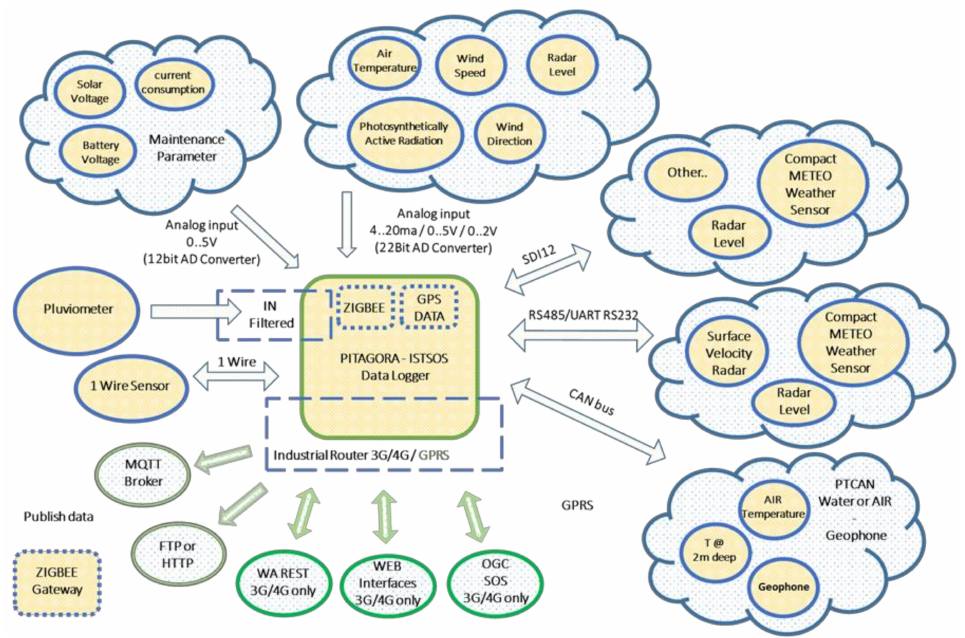
Figure 1. Scheme of PITAGORA